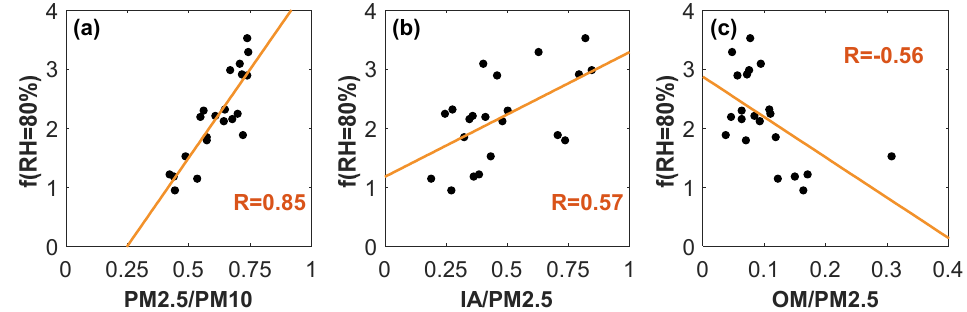
Figure 3. Hygroscopic growth of aerosol scattering at RH = 80% as a function of ( a ) mass fraction of PM 2.5 in PM 10 , and ( b ) mass fraction of inorganic aerosols, as well as ( c ) organic matter in PM 2.5.